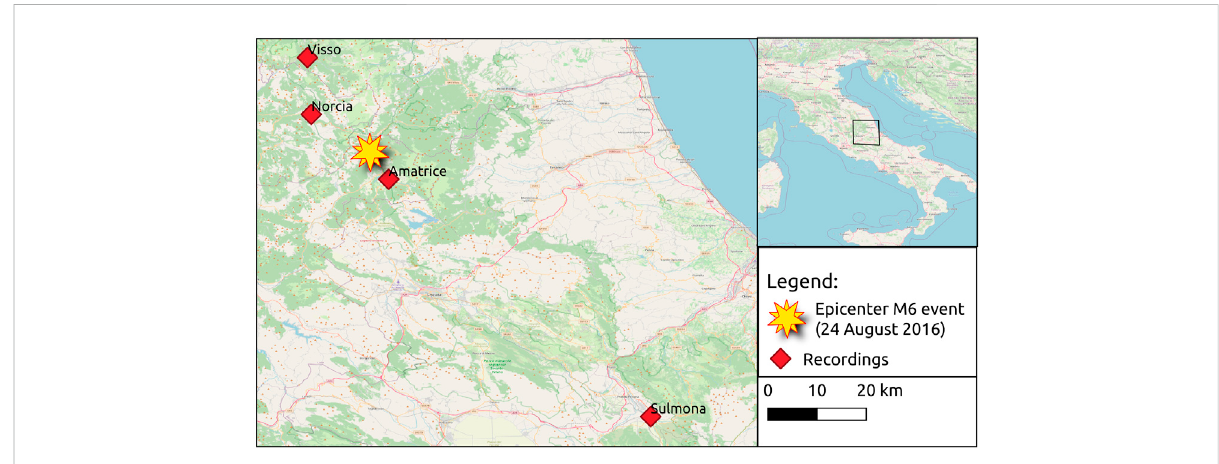
FIGURE 1 Map showing the locations of the four test sites Amatrice, Norcia, Visso and Sulmona (red rhombi) and the epicenter of the M6 event (yellow star).